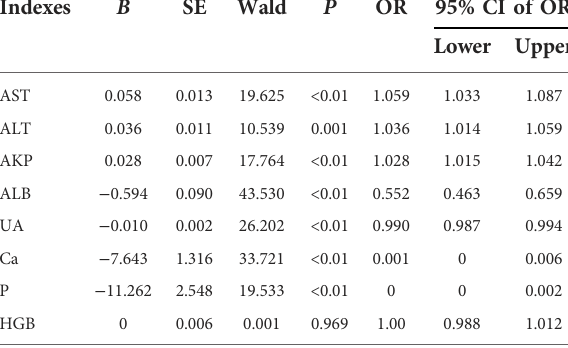
ALT, alanine aminotransferase; AST, aspartate aminotransferase; AKP, alkaline phosphatase; ALB, albumin; UA, uric acid; Ca, serum calcium; P, serum phosphorus; HGB,